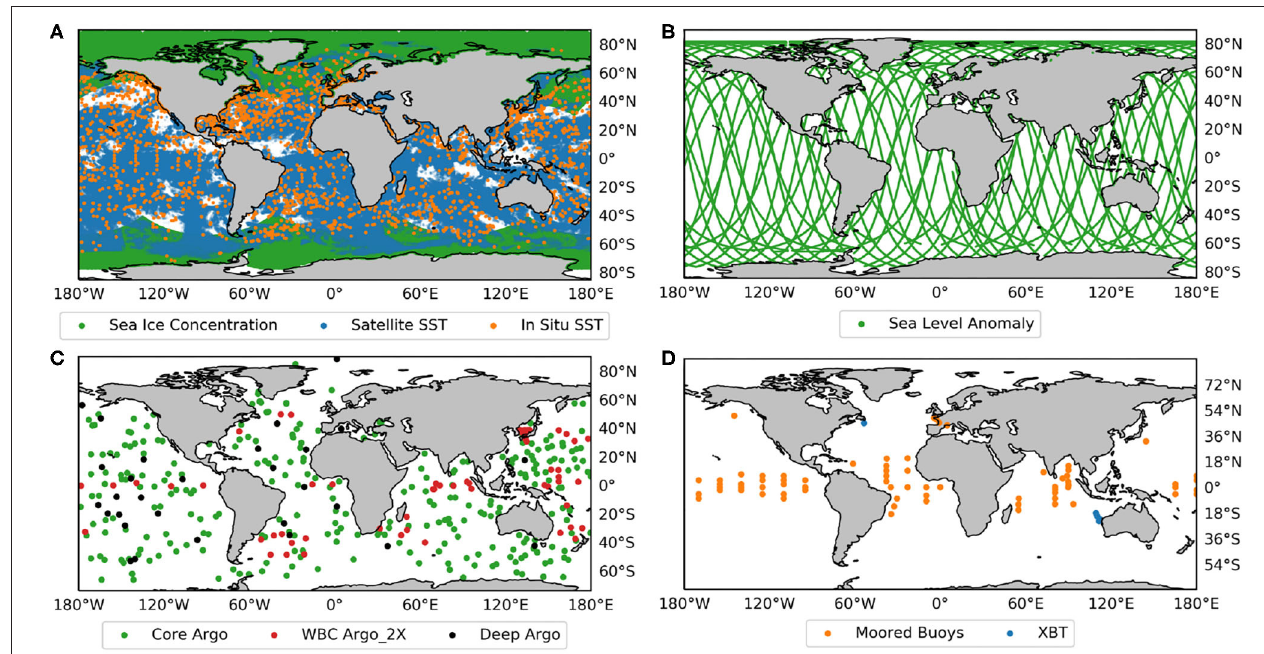
FIGURE 1 | Examples of synthetic observations coverage on 1 June 2009: (A) sea surface temperature and sea ice concentration, (B) sea level anomaly tracks, (C) profiles from Argo floats, and (D) profiles from moored buoys and